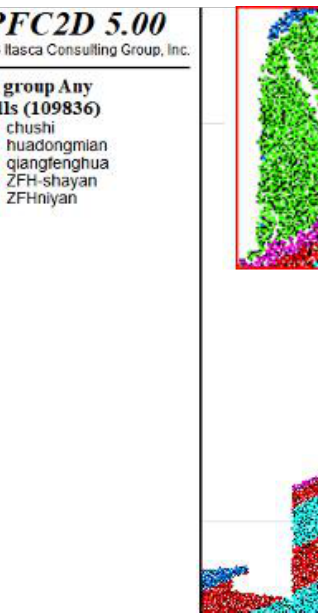
Figure 10. Displacement diagram in the later stage of collapse. The numerical simulation of the slope was completed, and Figure 11 was obtained. The slope has completely collapsed. The displacement of the upper particles is the larg- est, and the displacement of the lower particles is relatively small. This is due to the sliding of the rock mass at the front edge of the slope; shear failure occurs in the middle of the slope, the rock mass at the rear edge loses its support and slides downward, and the stress on the upper particles of the slope is greater than that of the lower particles, resulting in a significant change in the displacement of the upper particles of the slope. At this time, the rock mass at the front edge of the slide slides forward through the retaining